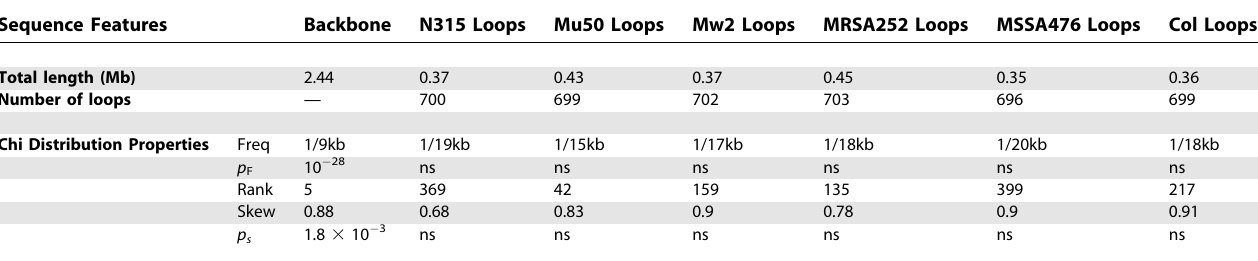
Table 2. Chi Is Overrepresented on the S. aureus